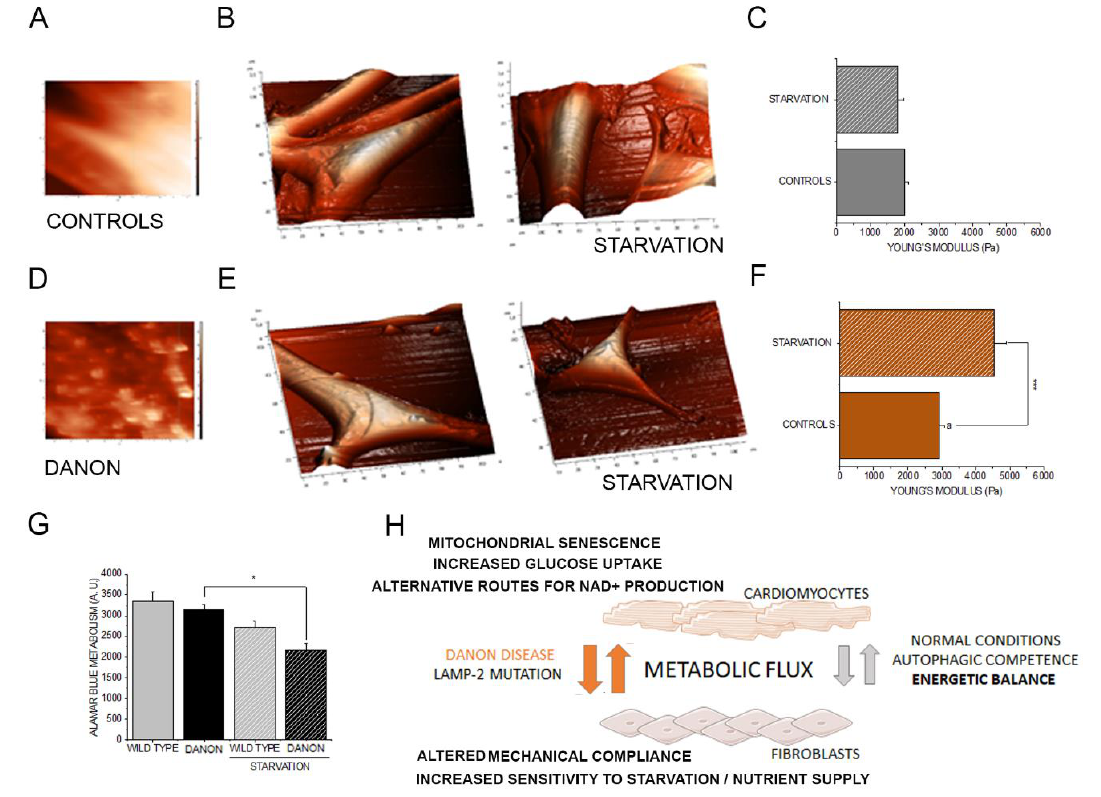
Figure 6. Morphological and functional characterization of fibroblasts via atomic force